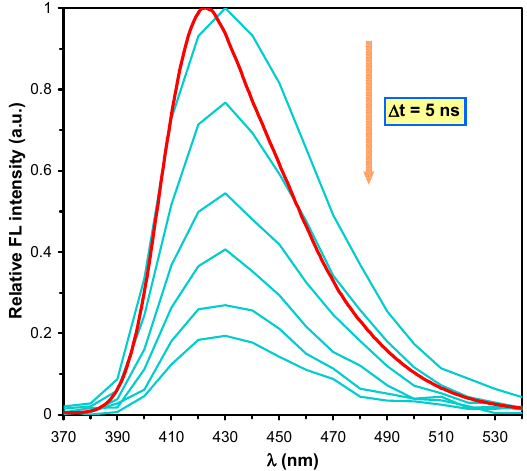
Figure 6. Time-resolved (blue curves) and steady-state emission (red curve) spectra of the 2,6-ICAN isomer in DMSO. The time-resolved emission spectra were recorded at 5 ns intervals.